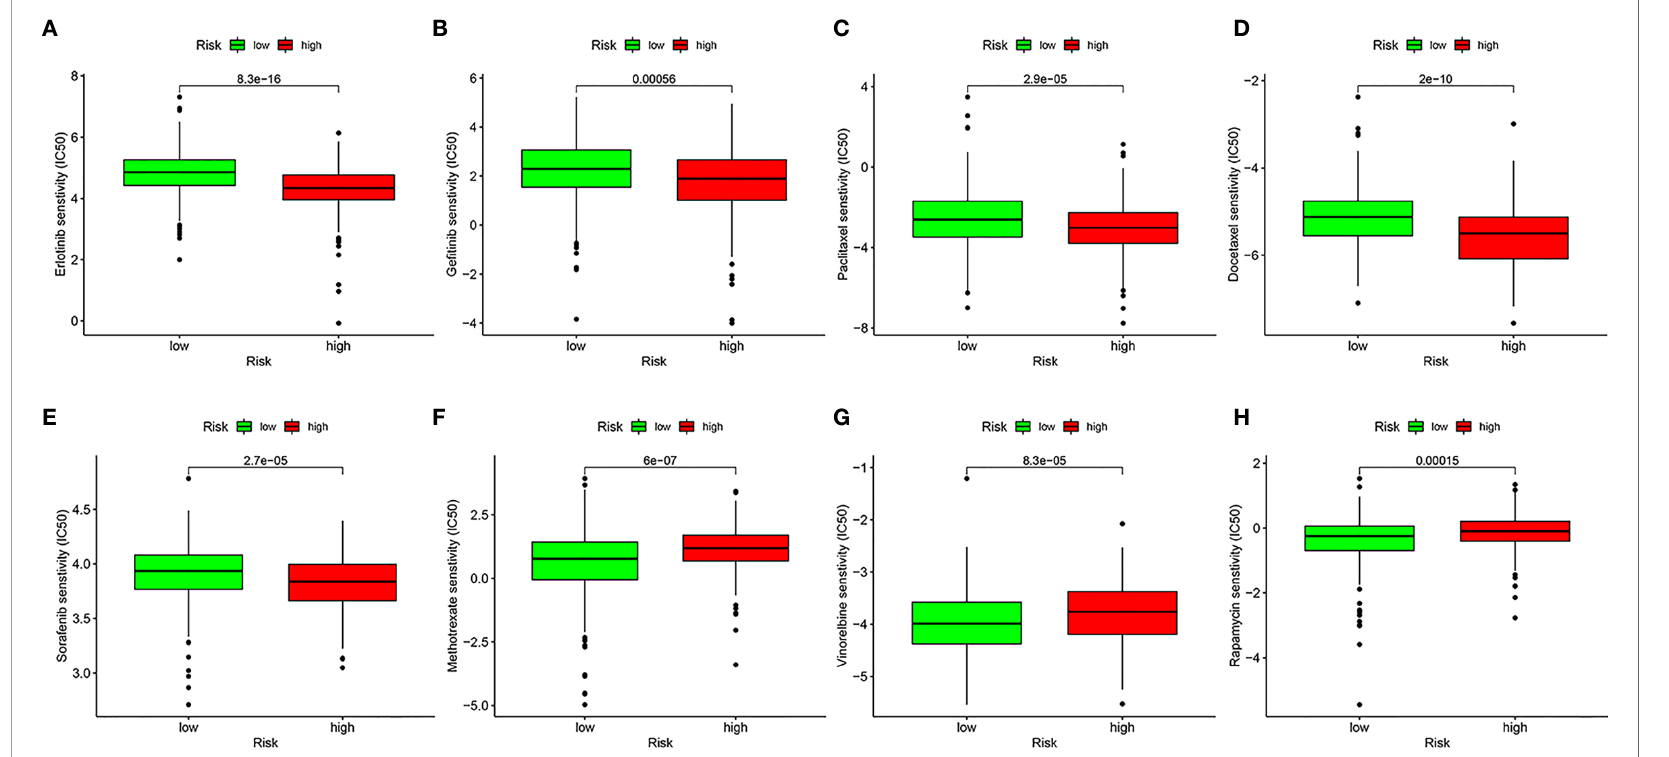
FIGURE 9 | Analysis of drug sensitivity. Difference in inhibitory centration (IC50) of Erlotinib (A) , Ge fi tinib (B) , Paclitaxel (C) , Docetaxel (D) , Sorafenib (E) , Methotrexate (F) , Vinorelbine (G) , and Rapamycin (H) for treatment of HNSCC in the high- and low-risk